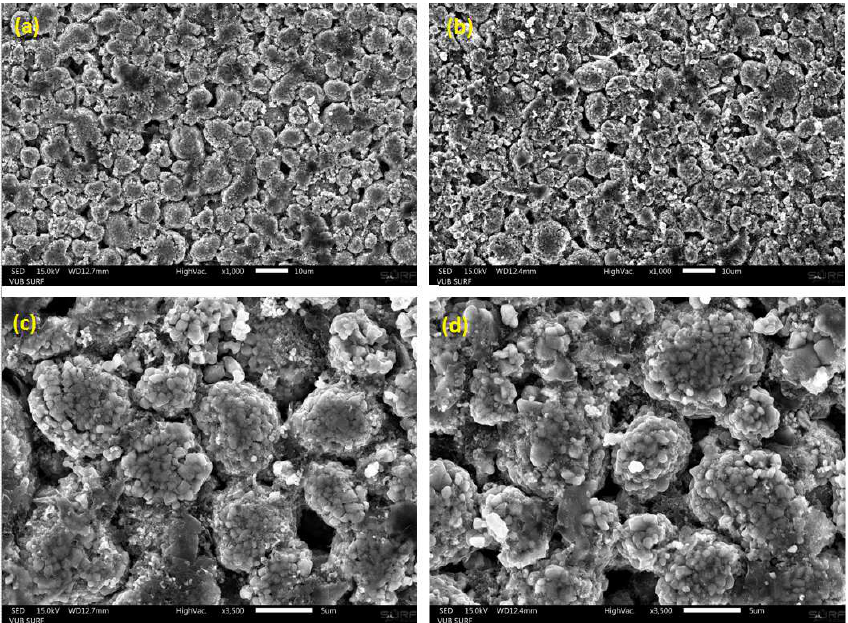
Figure 4. Scanning electron microscopy (SEM) micrograph of the uncycled and cycled NMC electrodes at × 1000 magnification rate ( a , b ) and × 3500 magnification rate ( c , d